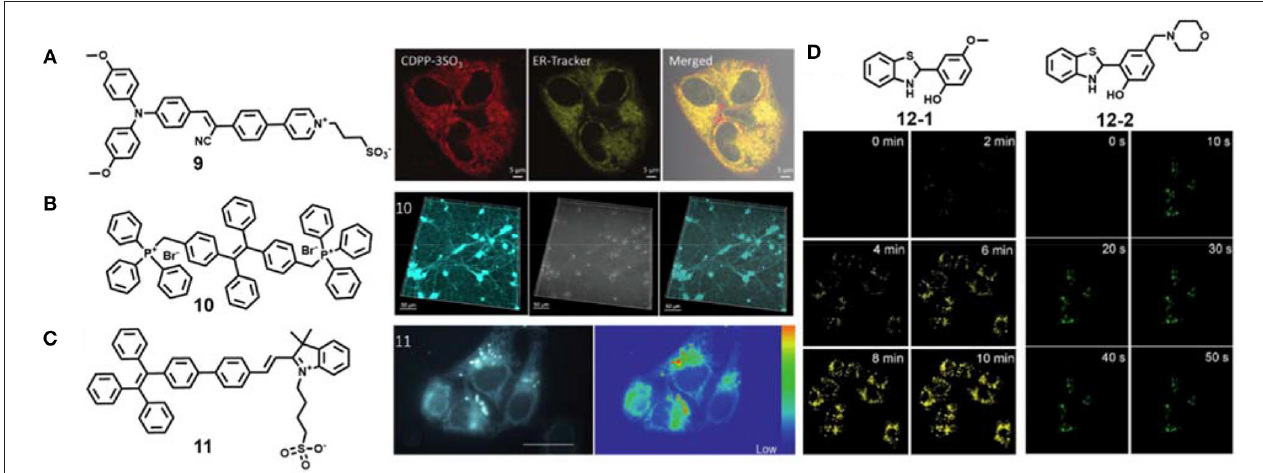
FIGURE 3 | (A) Chemical structure of AIE material 9 and two-photon endoplasmic reticulum imaging in live cells (reproduced with permission from Alam et al., 2020; Copyright 2020 Wiley-VCH). (B) Chemical structure of AIE material 10 and two-photon mitochondria imaging in live cells (reproduced with permission from Qian et al., 2015; This figure is extracted from an open access journal with thanks; Copyright 2015 The Optical Society). (C) Chemical structure of AIE material 11 and two-photon mitochondria and lipid droplet lifetime imaging in live cells (reproduced with permission from Chen et al., 2015; Copyright 2015 Wiley-VCH). (D) Chemical structures of AIE material 12-1 and 12-2 and two-photon photoactivated imaging of lipid droplets and lysosomes, respectively, in live cells (reproduced with permission from Li et al., 2018; This figure is extracted from an open access journal with thanks; Copyright 2018 The Royal Society of Chemistry).